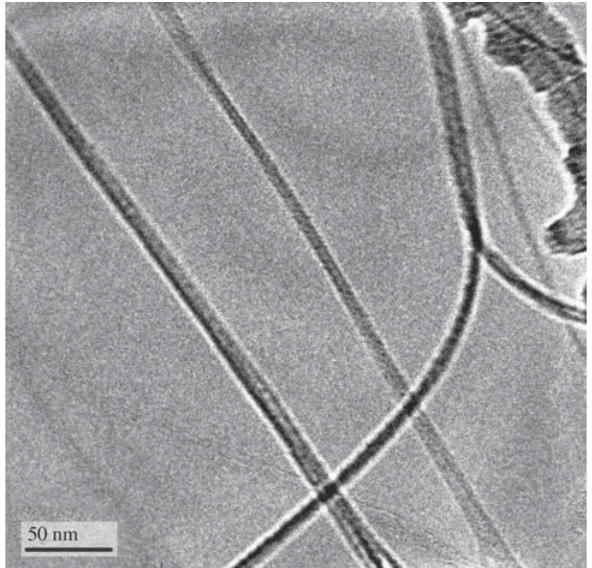
Figure 1. High Resolution Transmission Electron Microscopy of SWCNTs produced using the catalyst mixture: LiNi the arc-discharge